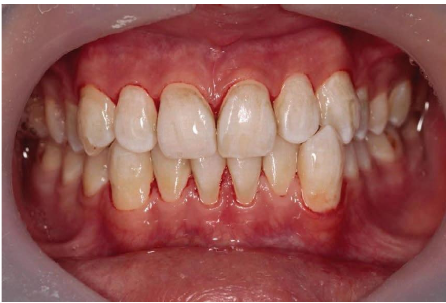
Figure 3: Teeth after air polishing treatment using air fow handy device with sodium bicarbonate.